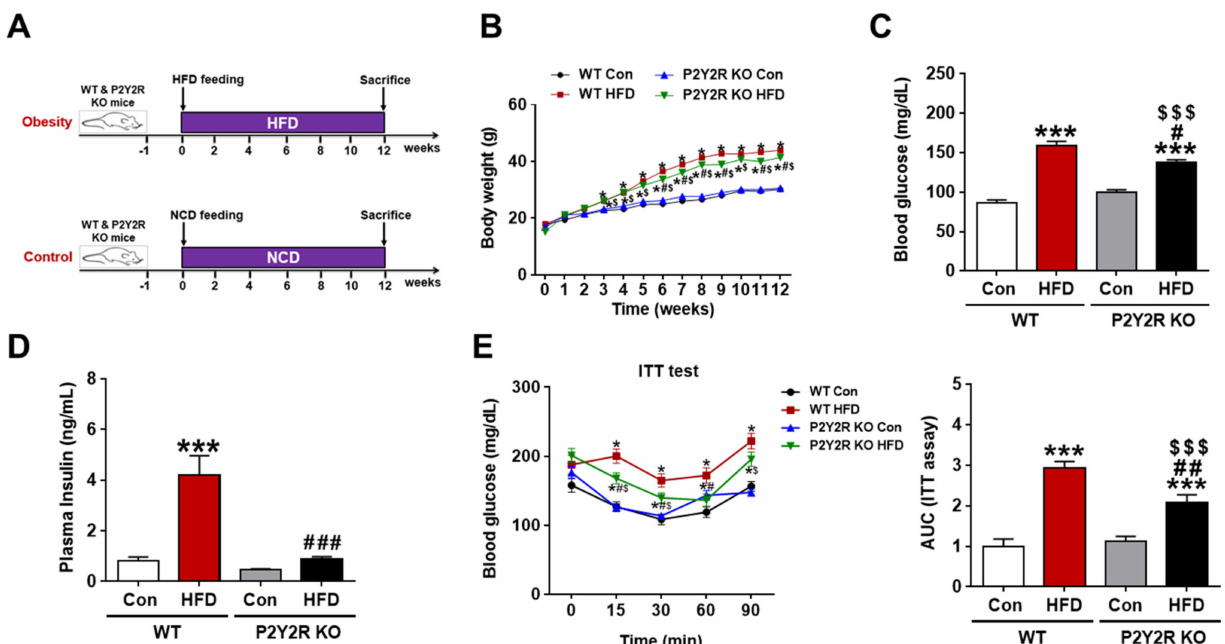
Figure 1. P2Y2R deficiency reduces insulin resistance in HFD-fed mice. ( A ) Experimental scheme for generating HFD- induced hepatic steatosis, where WT and P2Y2R KO mice were fed with a normal chow diet (NCD) or HFD for 12 weeks. ( B ) Weekly changes in the body weight in WT and KO mice for 12 weeks of feeding ( n = 9) ( C ) Blood glucose levels were determined in WT or KO mice after overnight (15 h) fasting ( n = 9). ( D ) Plasma insulin levels were measured after sacrifice in mice fed for 12 weeks ( n = 8). ( E ) Insulin tolerance test (ITT) were performed in WT or KO mice fed for 12 weeks, and the corresponding areas under the curves (AUC) were calculated ( n = 9). Data are presented as the mean ± SEM. One-way ANOVA was used for statistical analysis followed by Bonferroni’s multiple comparison test. * p < 0.05, *** p < 0.001 vs. WT control mice; and # p < 0.05, ## p < 0.01, ### p < 0.001 vs. WT HFD mice; and $ p < 0.05, $$$ p < 0.001 vs. KO control